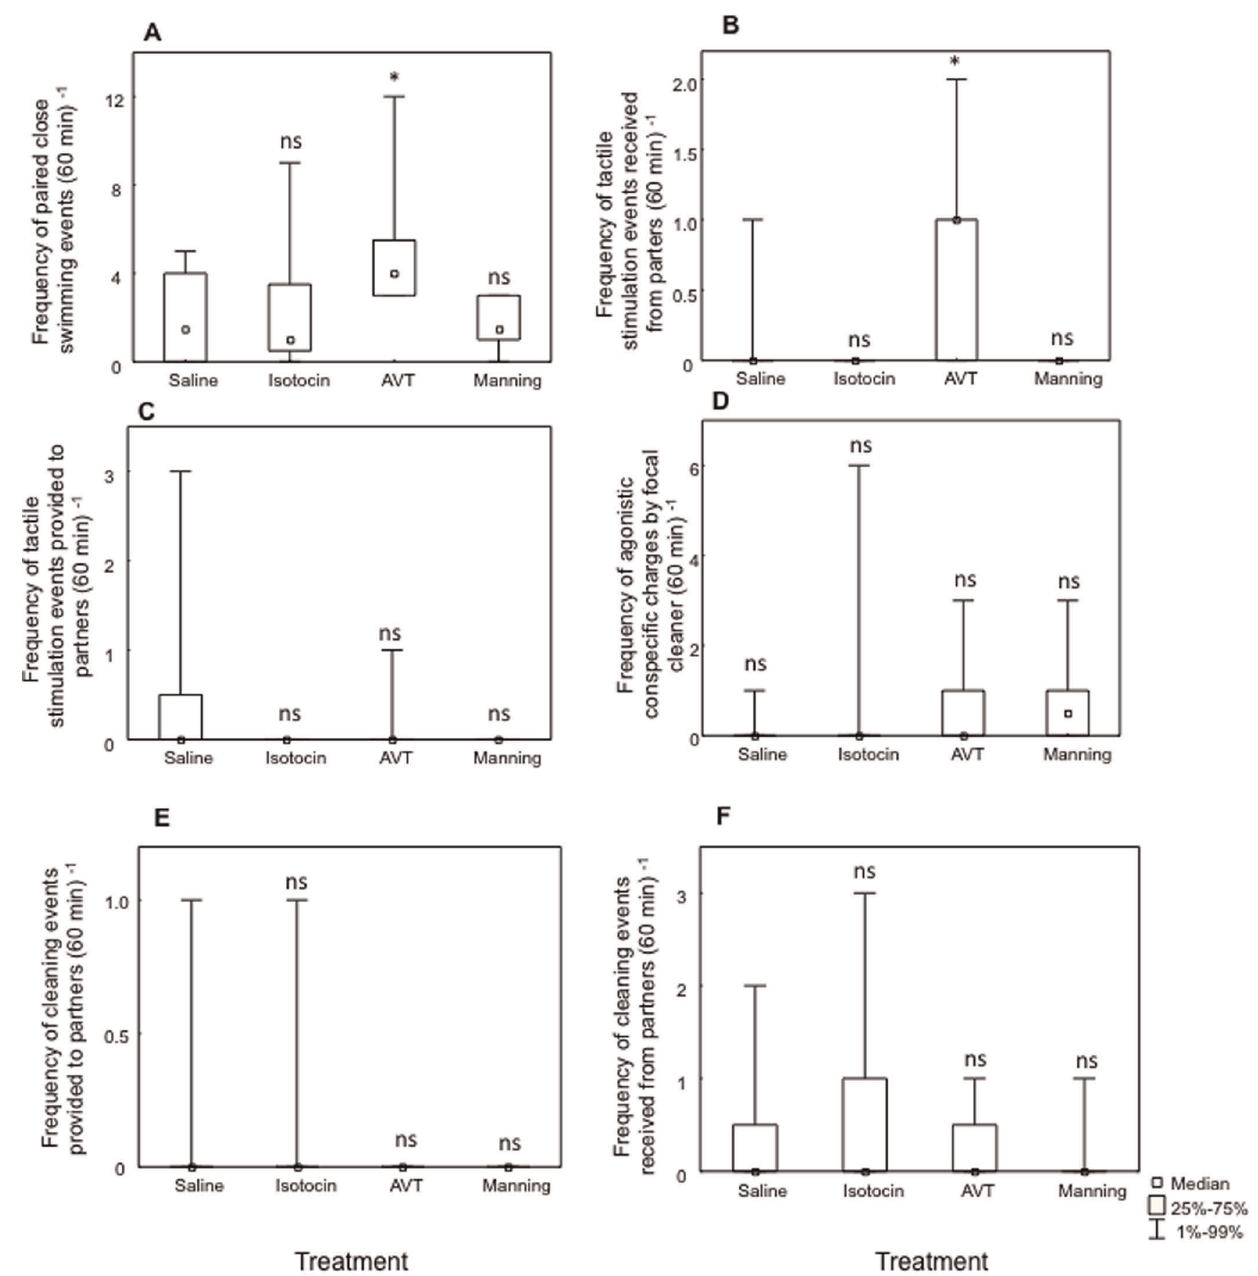
Figure 3. Field neuropeptide effects on measures of cleaner fish Labroidesdimidiatus conspecific related behaviour (all per 60 minute observation). A) frequency of paired-close swimming events, B) frequency of tactile stimulation events received from partners, C) frequency of tactile stimulation events provided to partners, D) frequency of agonistic conspecific charges by focal cleaner, E) frequency of cleaning events provided to partners and F) frequency of cleaning events received from partners. Medians and interquartile ranges are shown. Symbols above bars and sample sizes per treatment were the same as in Figure 1.